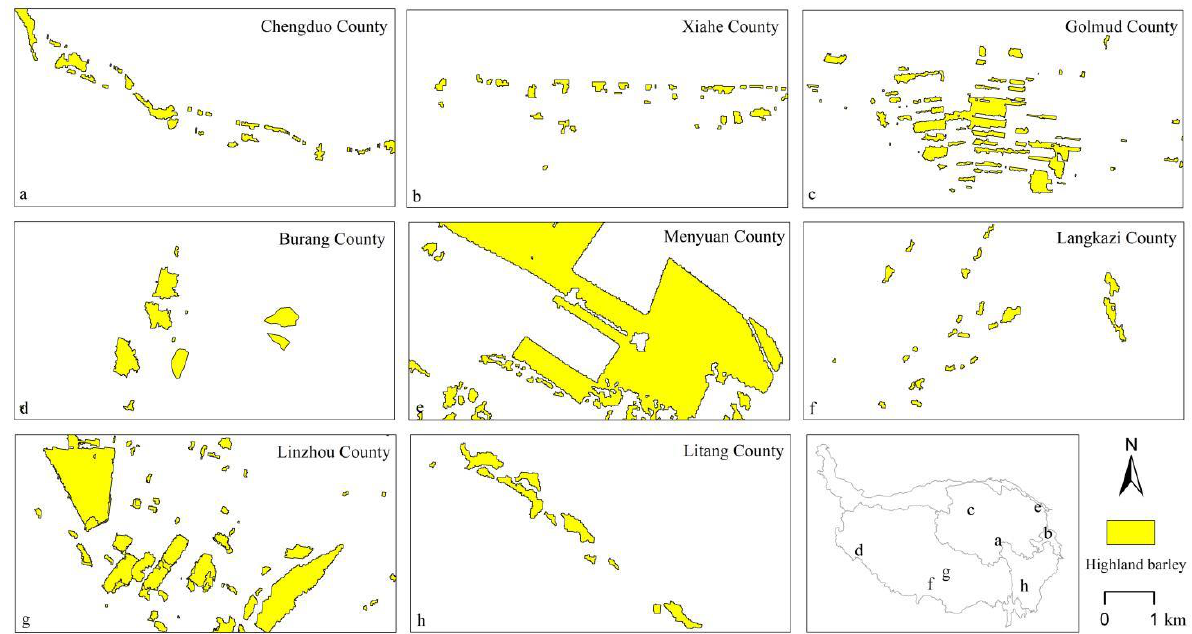
Figure 8. Distribution patterns of Highland barley under different elevation and different hydrological elements.